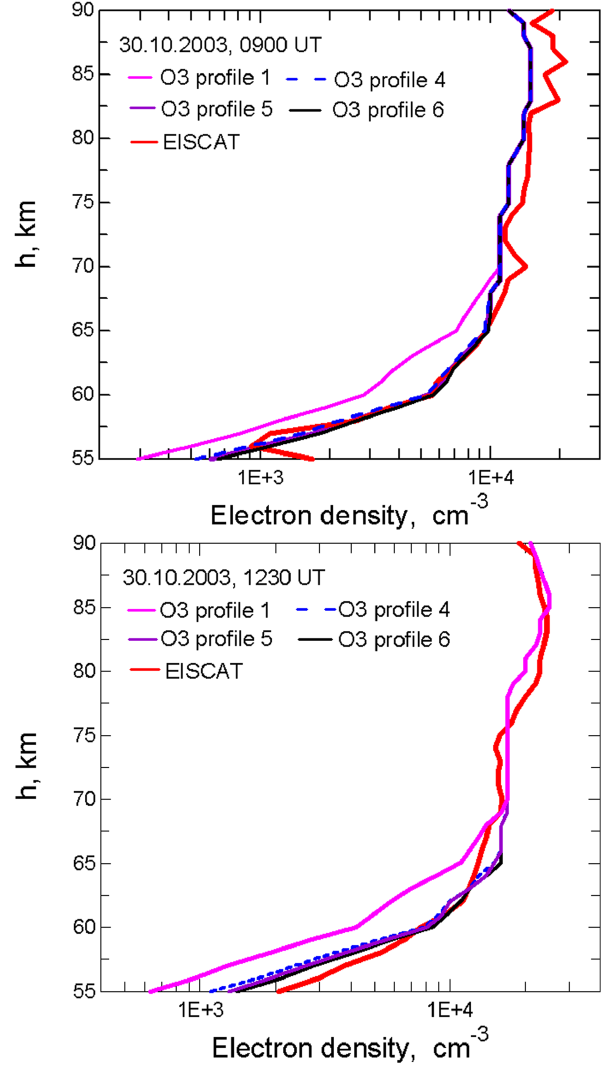
Fig. 10. Upper panel: electron density profiles measured and calcu- lated on 30 October 2003 at 09:00UT for zenith angle 84.6 ◦ . Lower panel: electron density profiles measured and calculated on 30 Oc- tober 2003 at 12:30UT for zenith angle 85.8 ◦ . The O 3 -profiles 1, 4, 5 and 6 are used to obtain the modeled